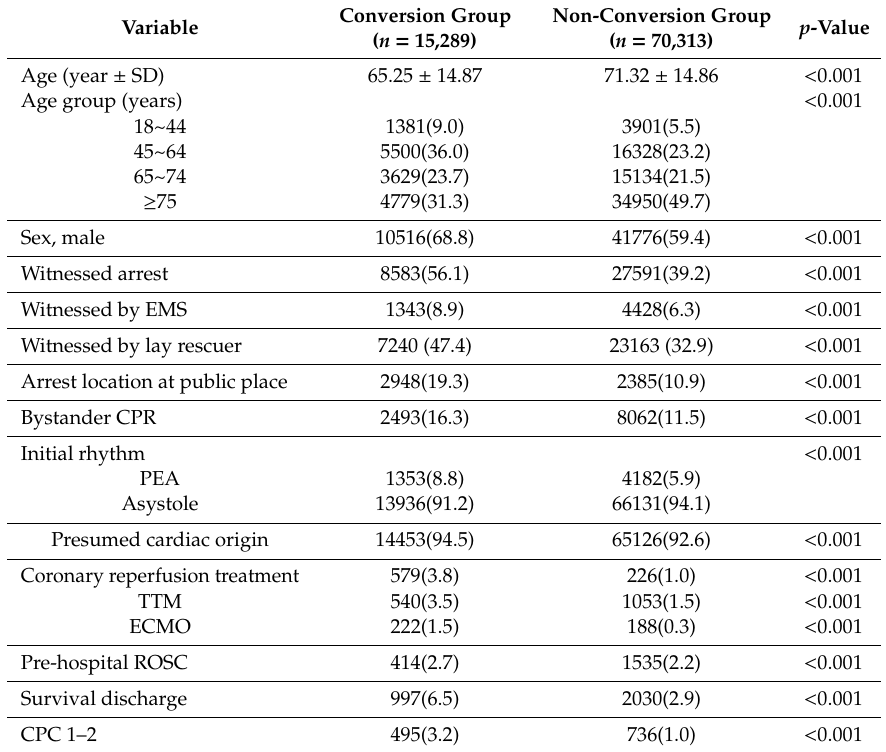
Table 3. Resuscitation variables and outcome according to conversion to shockable rhythm in the study